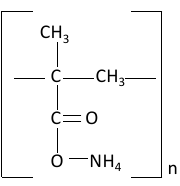
Figure 2. The molecule structure of dispersant Dolapix CE 64.